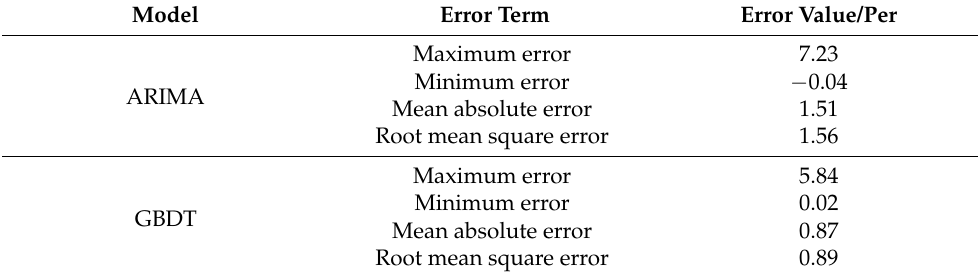
Table 8. Comparison of prediction